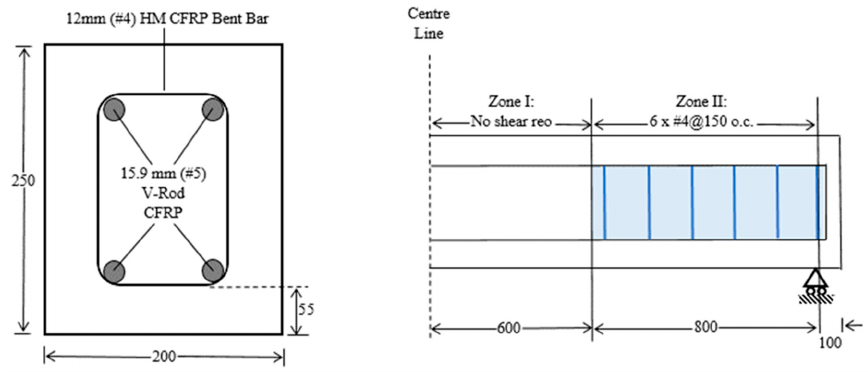
Figure 1. Reinforcement details of BGF1 and BGF2 (all the dimensions are in mm).